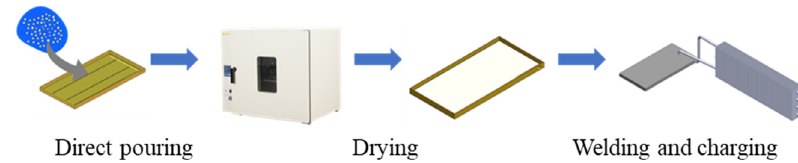
Figure 3. Production process of the direct pouring LHP.